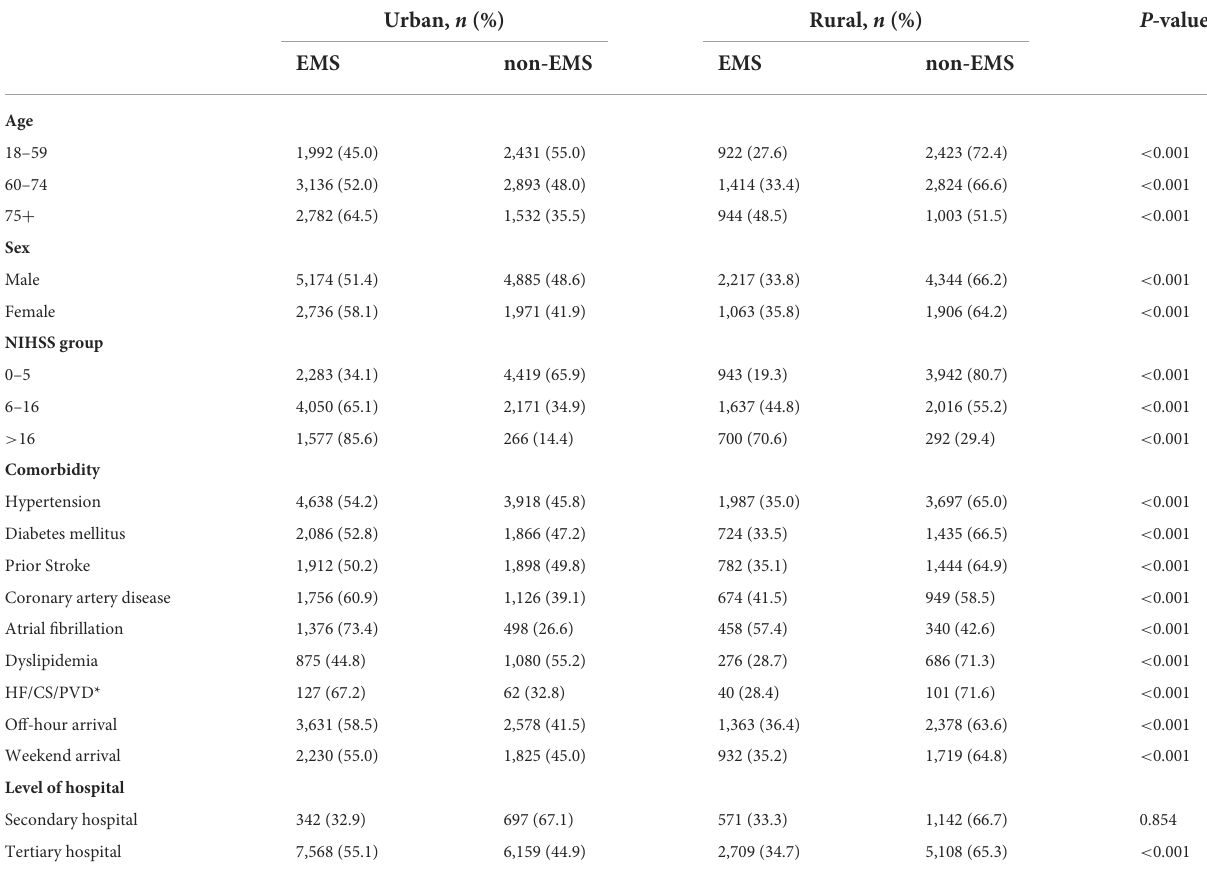
TABLE 2 Percentage of EMS utilization in AIS patients with different characteristics. Urban, n (%) Rural, n